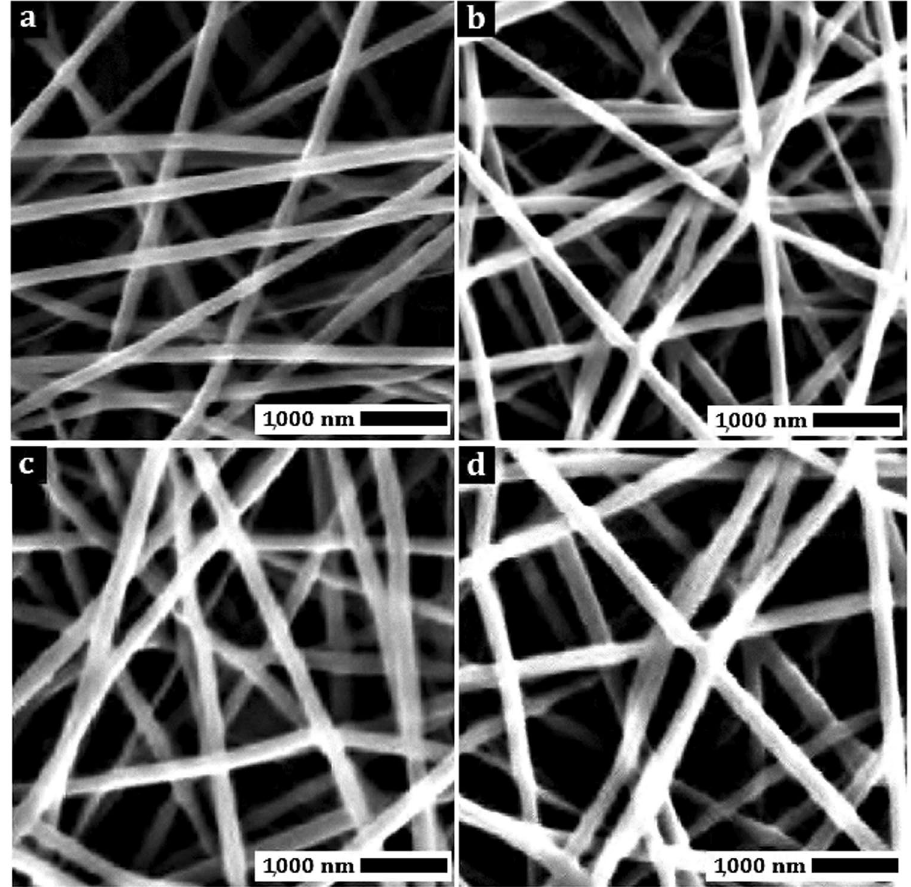
Figure 5. SEM images of ( a ) PBSGL0, ( b ) PBSGL10, ( c ) PBSGL20, and ( d ) PBSGL40 nanofibers.